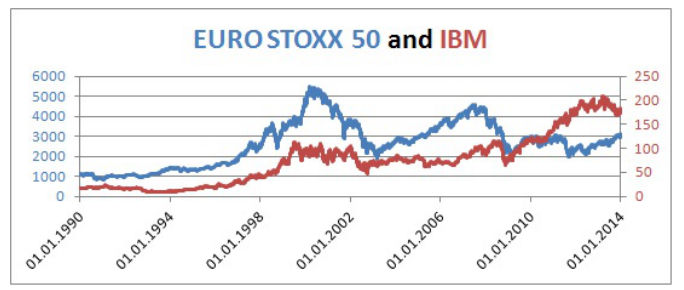
Figure 1. Historical series of EURO STOXX50 (primary axis) and IBM (secondary